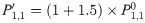
Distribution of conditional signal delay for network count data aggregated at (a) W = 2 (b) W = 5 (c) W = 10 and (d) W = 20 level. P1,1′=(1+1.5)×P1,10.